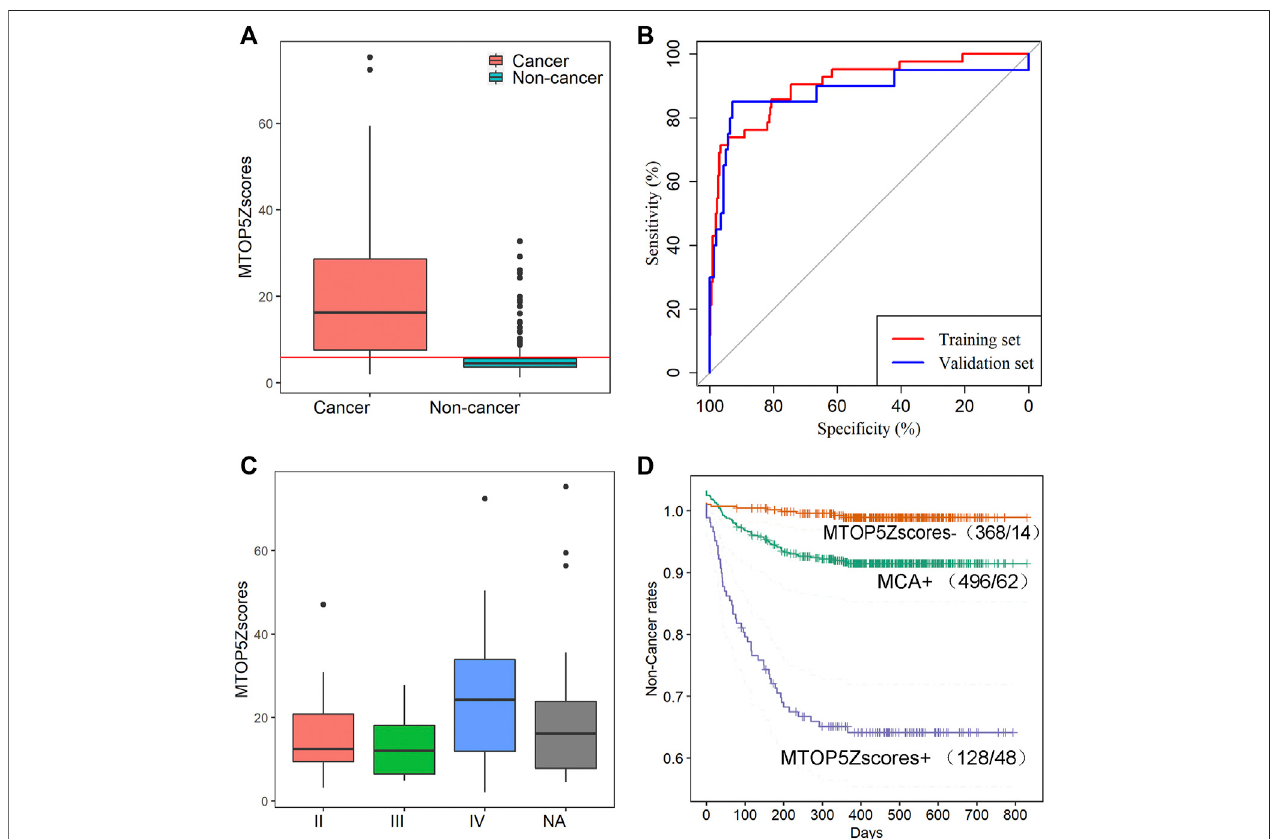
FIGURE 3 | MTOP5Zscore analyses of 62 cancer cases in this study. (A) The comparison of MTOP5Zscores between 62 maternal cancer cases and 434 non- cancer participants; the red line represents the cutoff of 5.94 to determine MTOP5Zscore-positive. (B) The ROCs for MTOP5Zscores in the training and validation sets. (C) The comparison of MTOP5Zscores in maternal cancer patients at different cancer stages. (D) The Kaplan – Meier plot shows non-cancer rates for MCA-positive, MTOP5Zscore-positive, and MTOP5Zscore-negative groups.